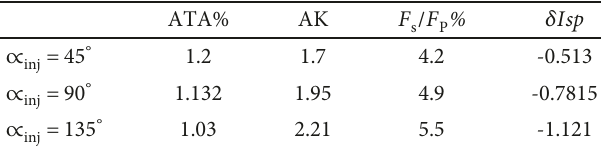
Table 10: SITVC performance parameters with respect to divergence half angle at M